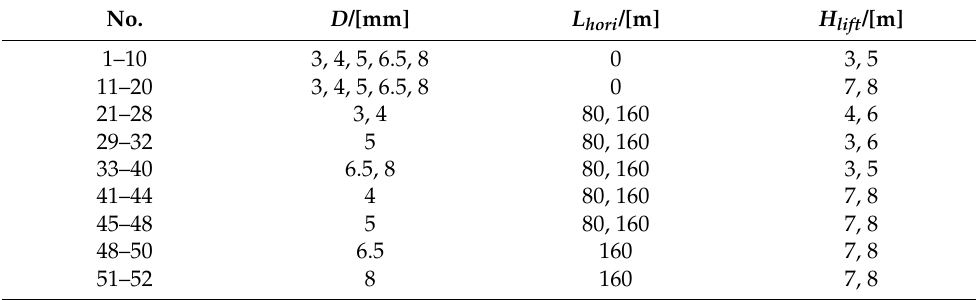
Table 1. Experimental schemes of siphon drainage (T = 25 ◦ C, P la = 100.53